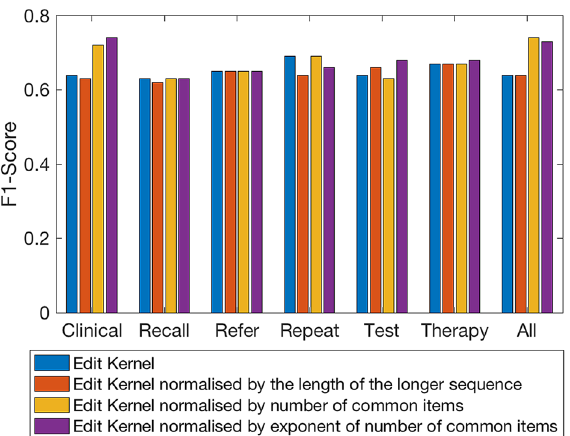
Figure 6. Bar chart showing the F1-scores obtained by applying the 4 kernel functions to the